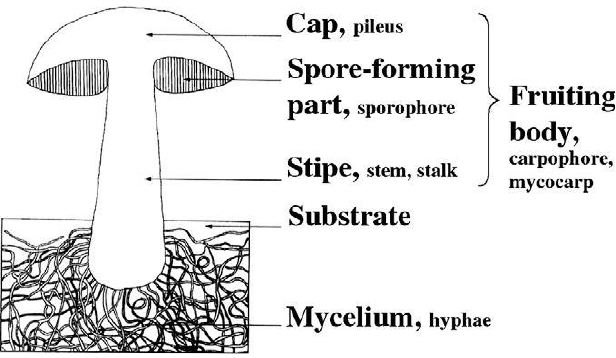
Figure 4. Schematic illustration of the individual functional components of the mushrooms. Reproduced from [95], with permission from Elsevier, 2009.